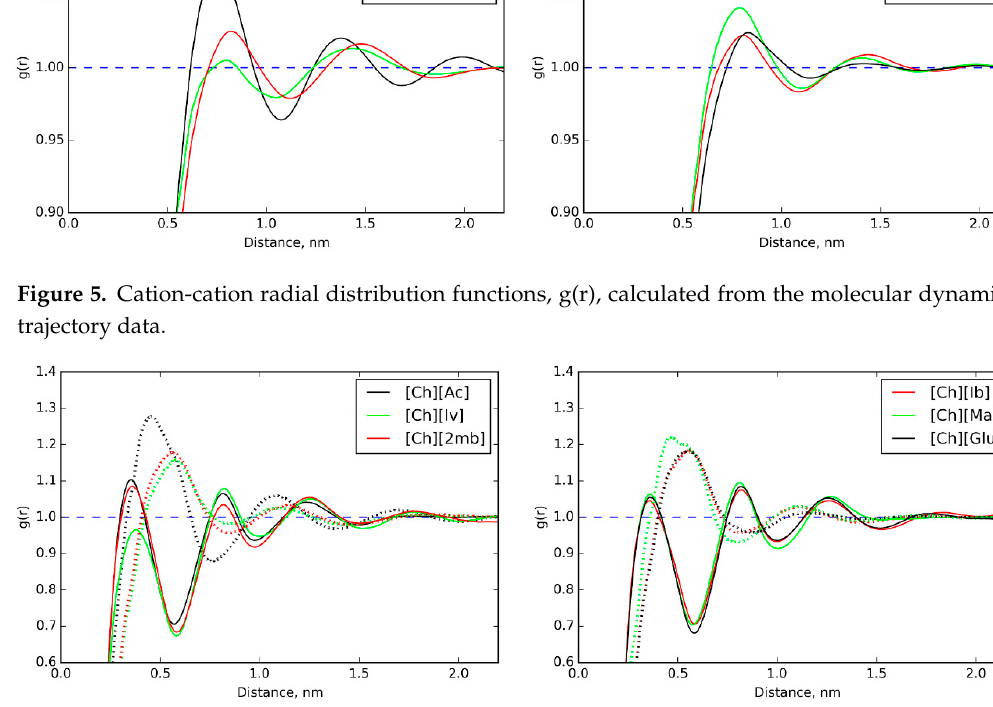
Figure 6. Radial distribution functions, g(r), of cation ‒ anion correlation (dotted line) and cation ‒ choline O-H correlation (solid line) calculated from the molecular dynamics trajectory data.